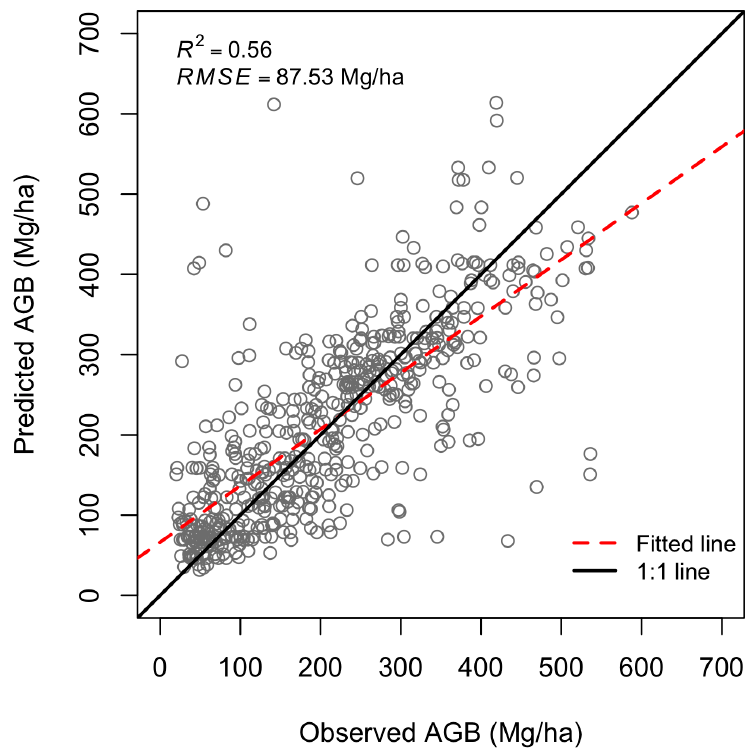
Figure 5. Evaluation of predicted forest AGB using validation ground inventory dataset at the plot level. R 2 represents the adjusted coefficient of determination, RMSE represents the root-mean-square error.